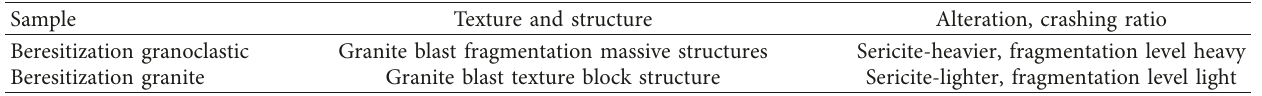
Figure 1: Open pit panorama. Table 1: List of the geological characteristics of the rock engineering.